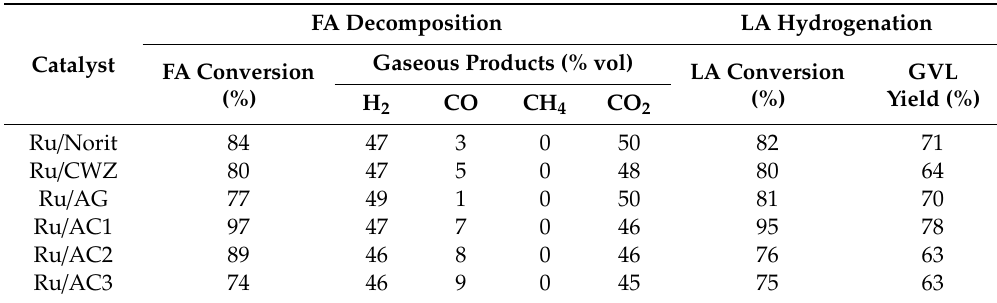
Table 4. Activity of ruthenium catalysts in formic acid decomposition and levulinic acid hydrogenation with external hydrogen source.